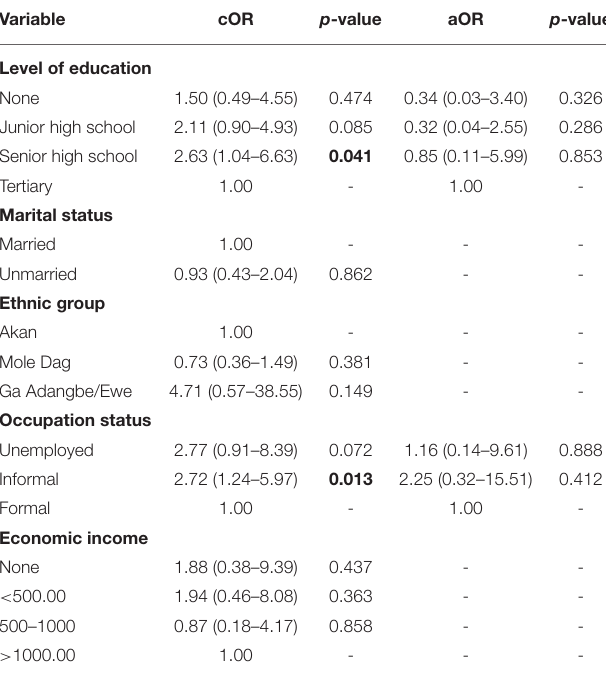
TABLE 3 | Multivariate Logistic regression of sociodemographic and obstetric predictors of preterm birth among study participants. Variable